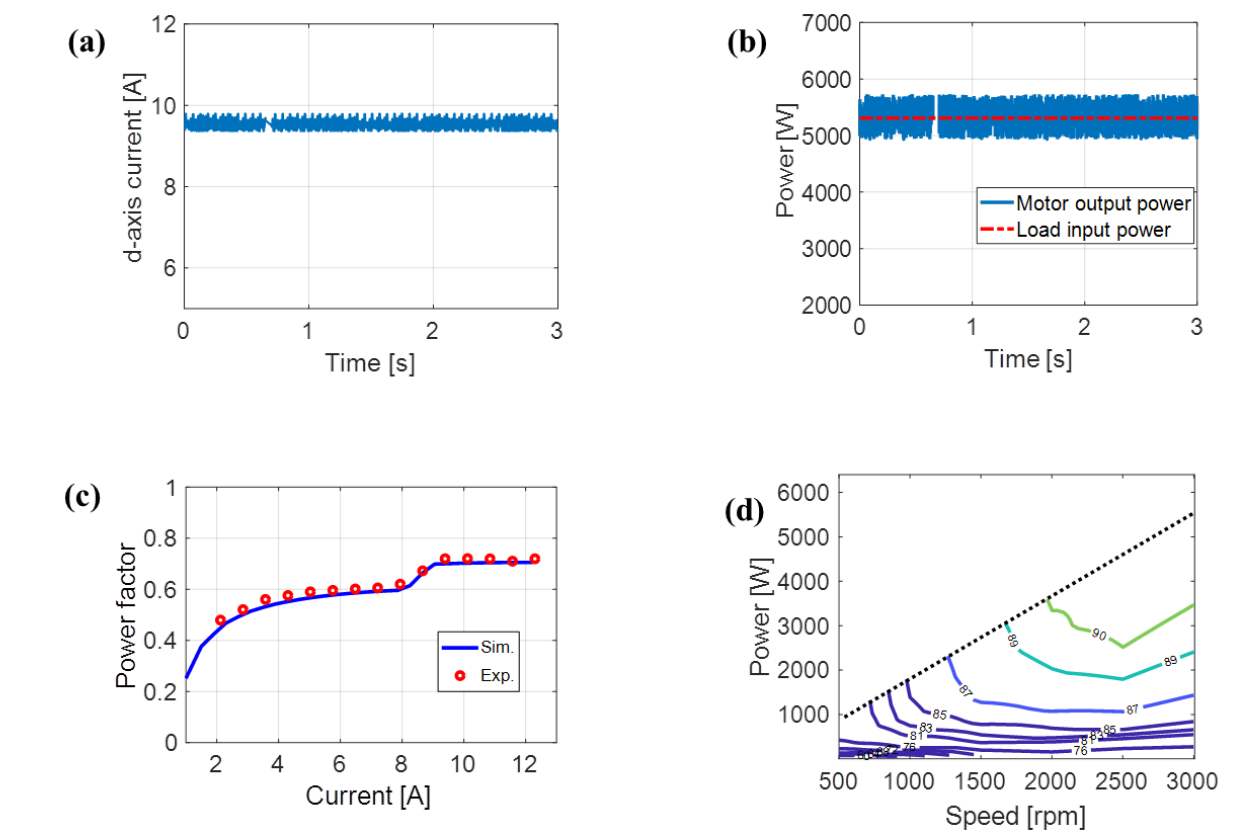
Figure 8. The d-axis current of the SynRM at the rated condition ( a ); power of the motor and pump at the rated condition ( b ); measured motor power factor at different currents ( c ); measured efficiency map of the whole drive system (motor + inverter) ( d ).